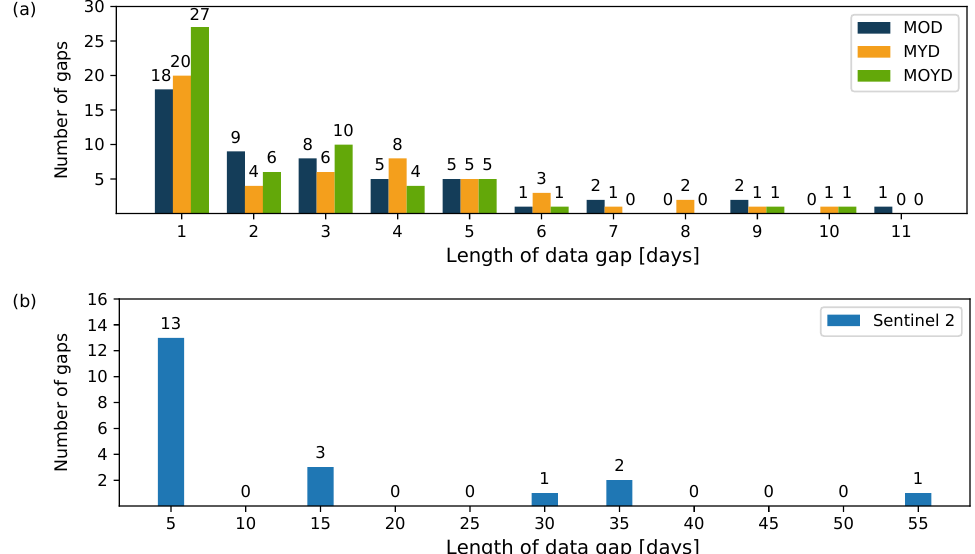
Figure 7. Length of data gaps in the ( a ) MOD, MYD, MOYD, and ( b ) Sentinel-2 data sets caused by using a cloud cover threshold of 70%.